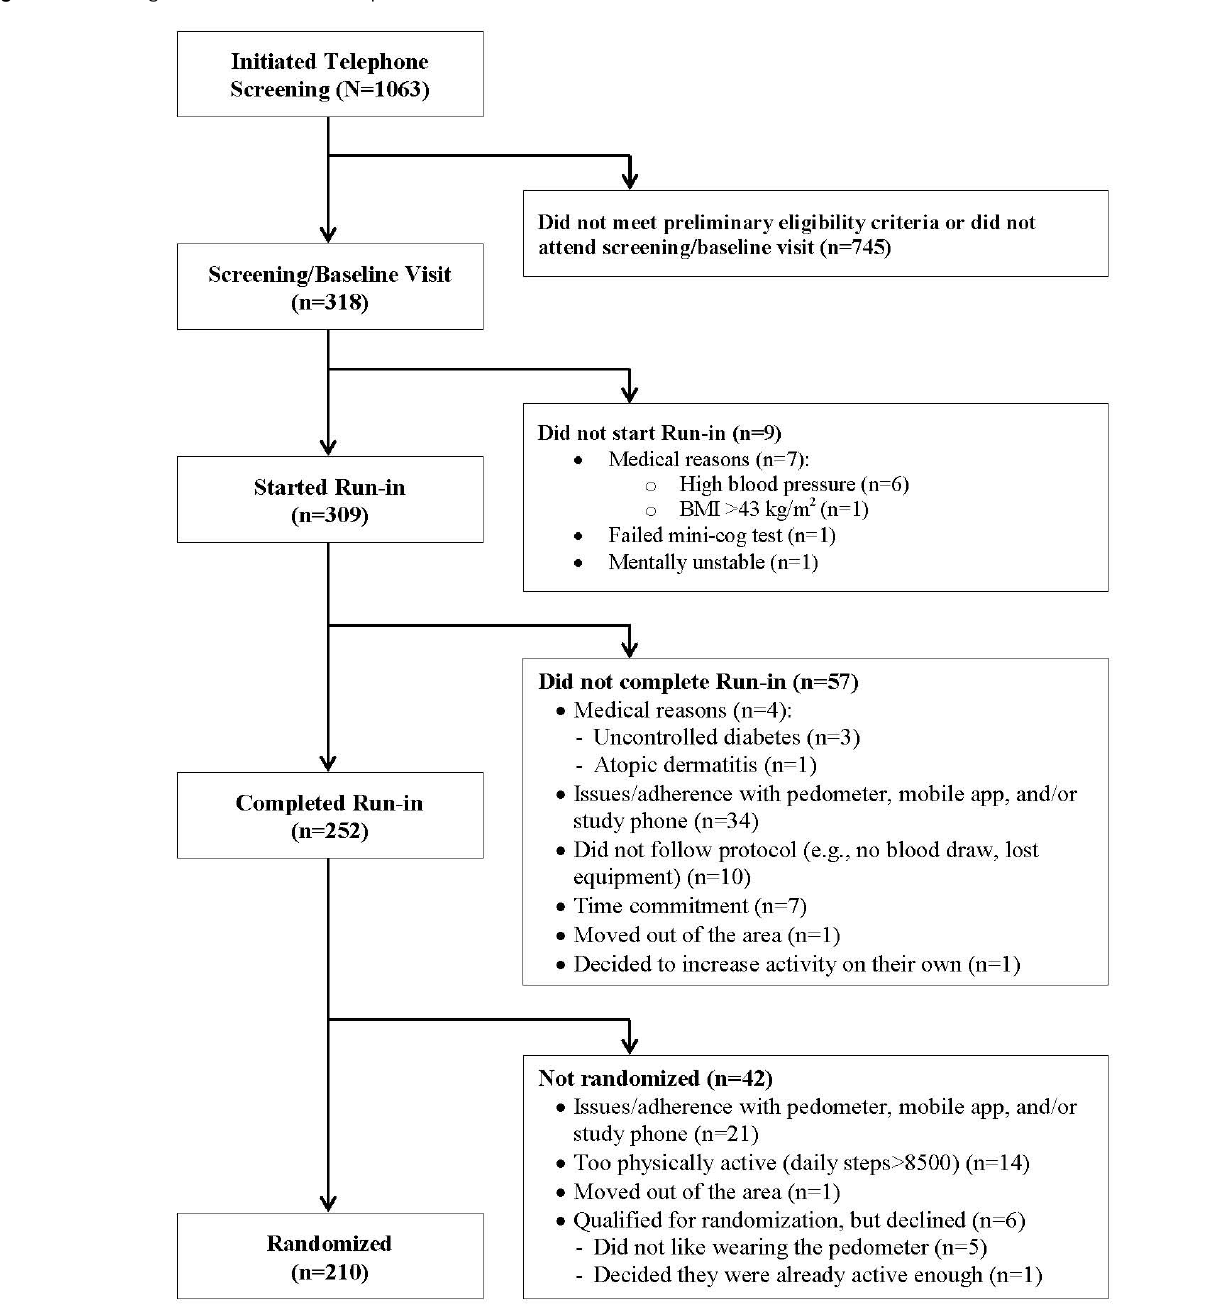
Figure 1. Flow diagram of the mPED run-in period.